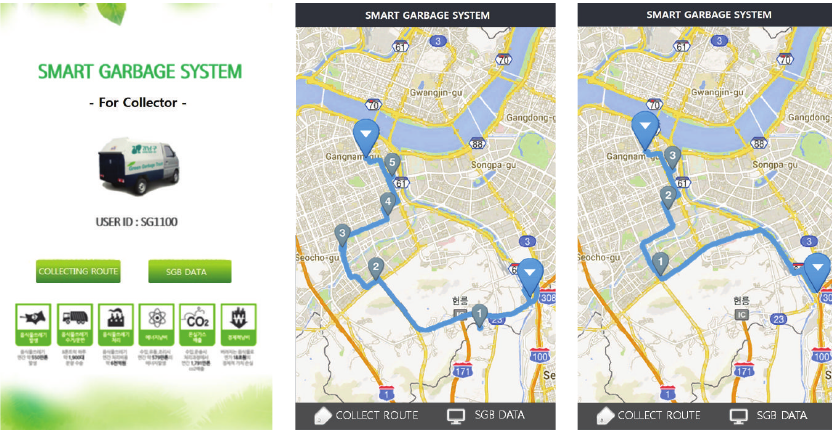
Figure 7: Mobile application for the